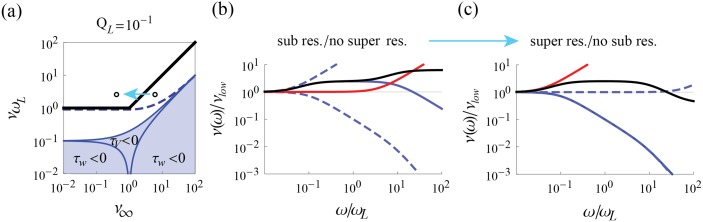
An example of filter shaping: attenuation at high frequencies uncovers an amplified band of intermediate frequencies.(a) The shape space representation showing the region of accessible filters (white) for Q
L = 0.1. The blue regions exhibit unstable filters. Filters obtained from points above the thick black line are spiking resonant. Filters obtained from points above the black dashed line are voltage resonant. The arrow illustrates a path in shape space along which ν
∞ is decreased. (b) and (c) show the beginning and end filters along the path in (a). For (b) and (c), blue dashed lines are the high and low pass components of the current-to-voltage filter, which itself is shown in solid blue. Shown in red is the voltage-to-spiking filter which combined with the current-to-voltage filter gives the full filter, shown in black.